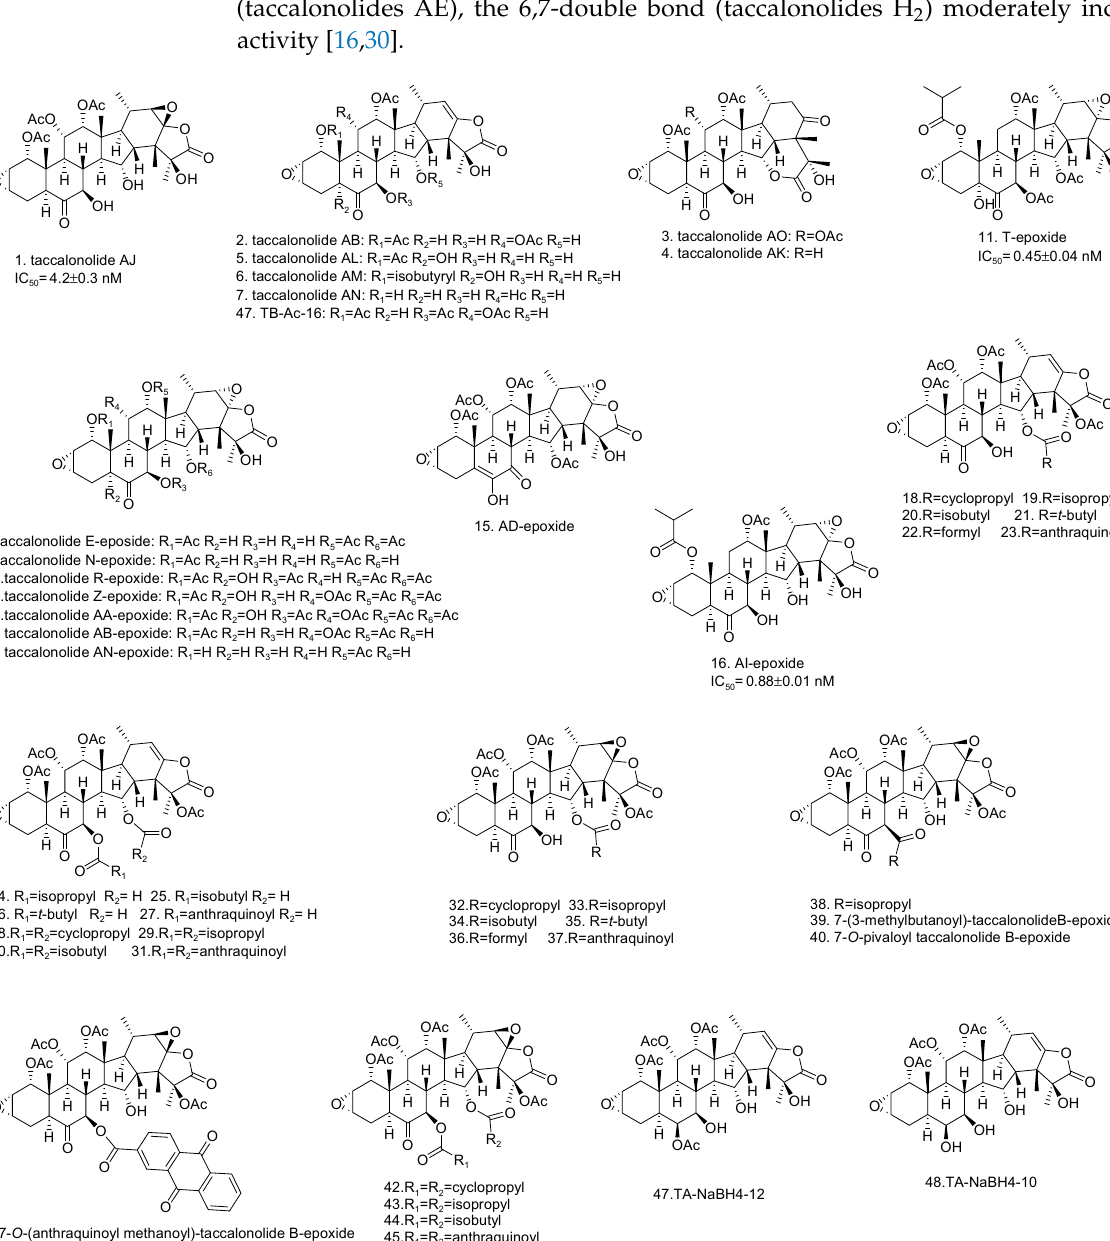
37.R=anthraquinoylO B-epoxideO 35. R= t -butyl 36.R=formyl